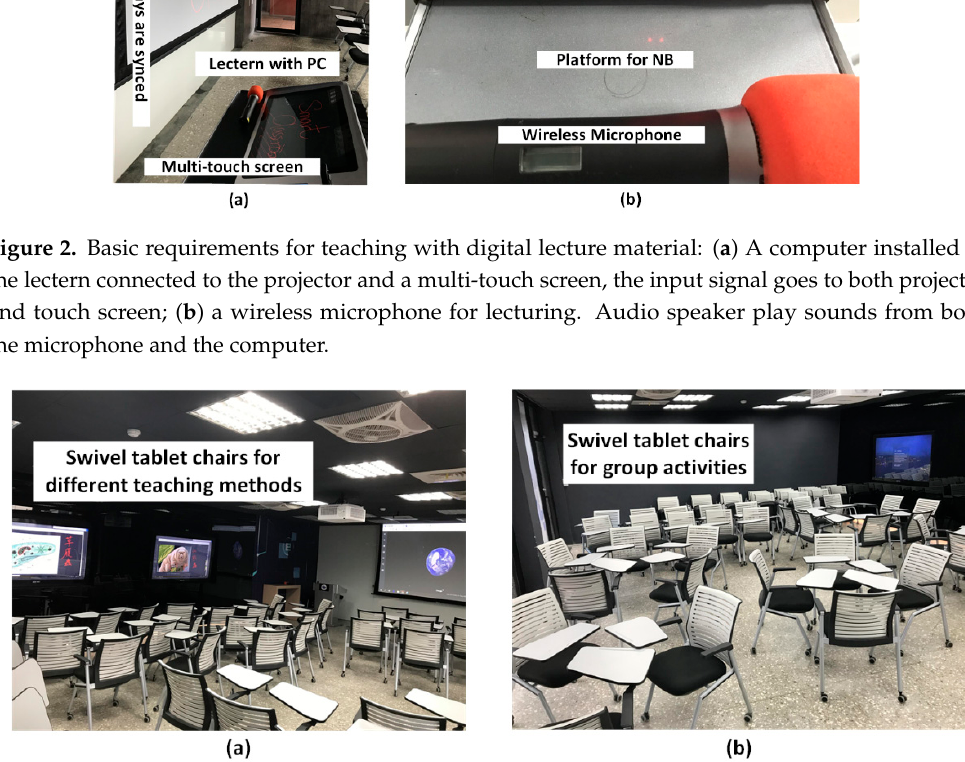
Figure 3. Swivel tablet chairs for dynamic seat rearrangement: ( a ) seats can be adjusted dynamically to face toward different interactive boards and ( b ) round table with any amount of seats.